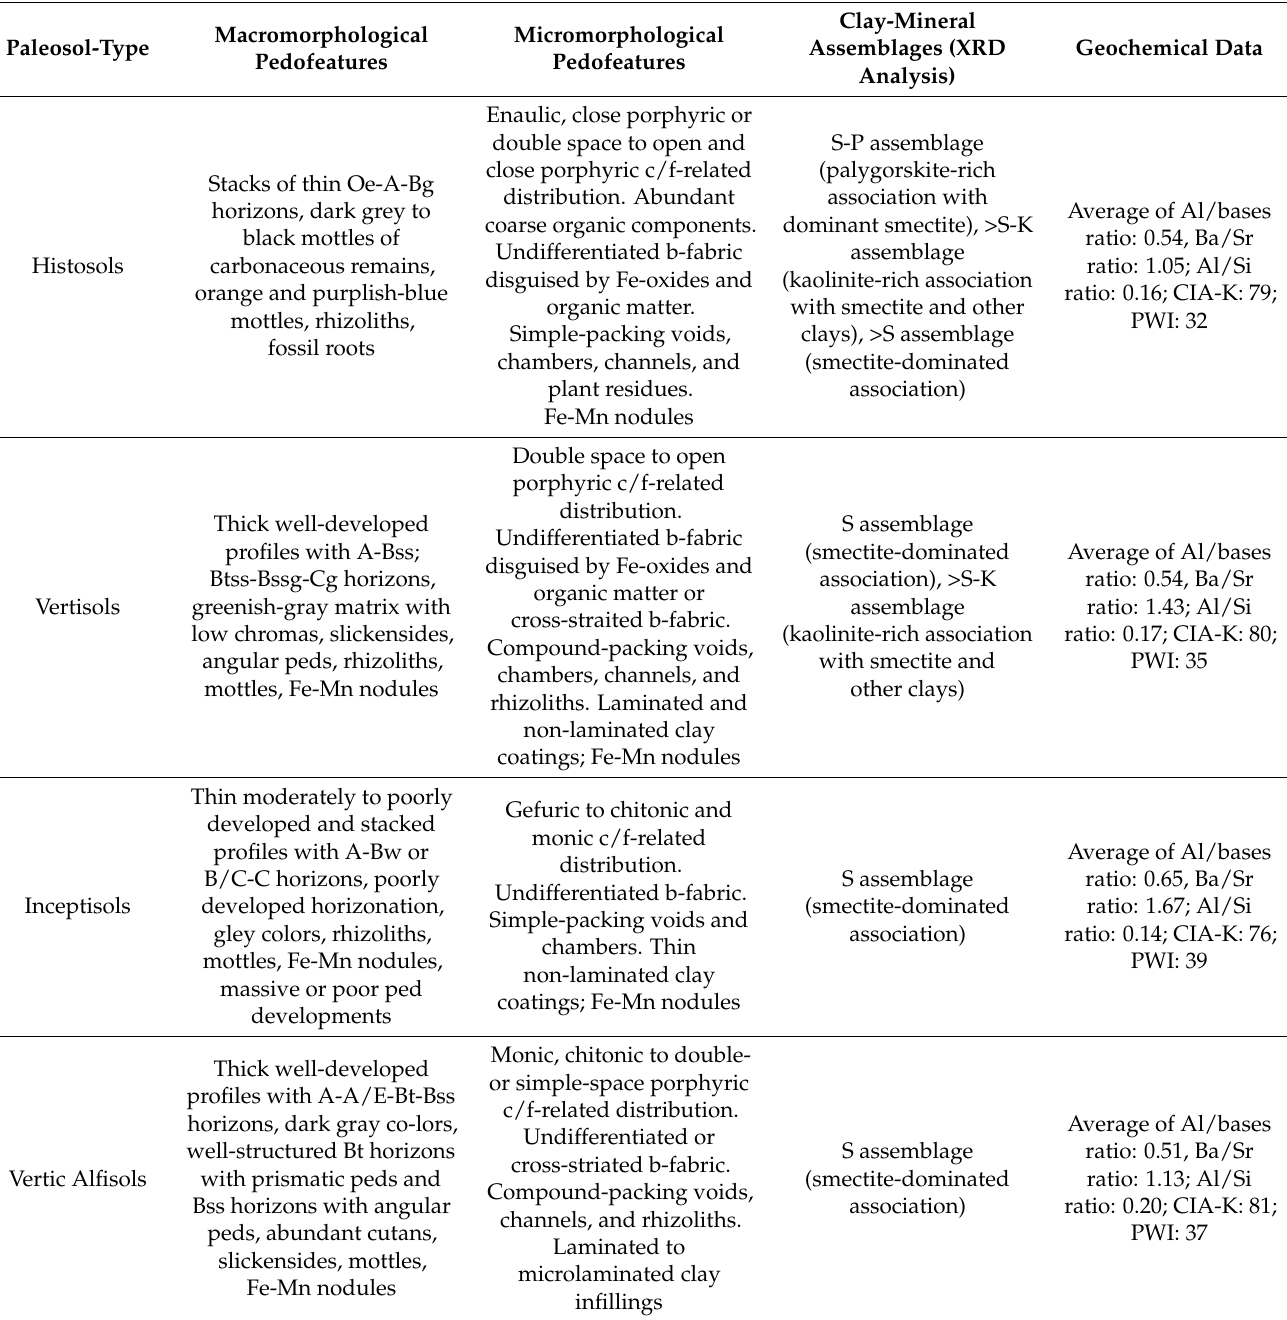
Table 1. Main macro- and micromorphological pedofeatures, clay-mineral assemblages, and geochemical data of the paleosols of the Mata Amarilla Formation. The coarse/fine-grained (c/f) related distribution terms: enaulic, porphyric, monic, gefuric and chitonic describe the spatial distribution of coarse grains and soil matrix. Birefringence fabric (b-fabric) of the paleosol matrix terms (undifferentiated and cross-striated) describe the orientation of the clay-minerals packages in the paleosol